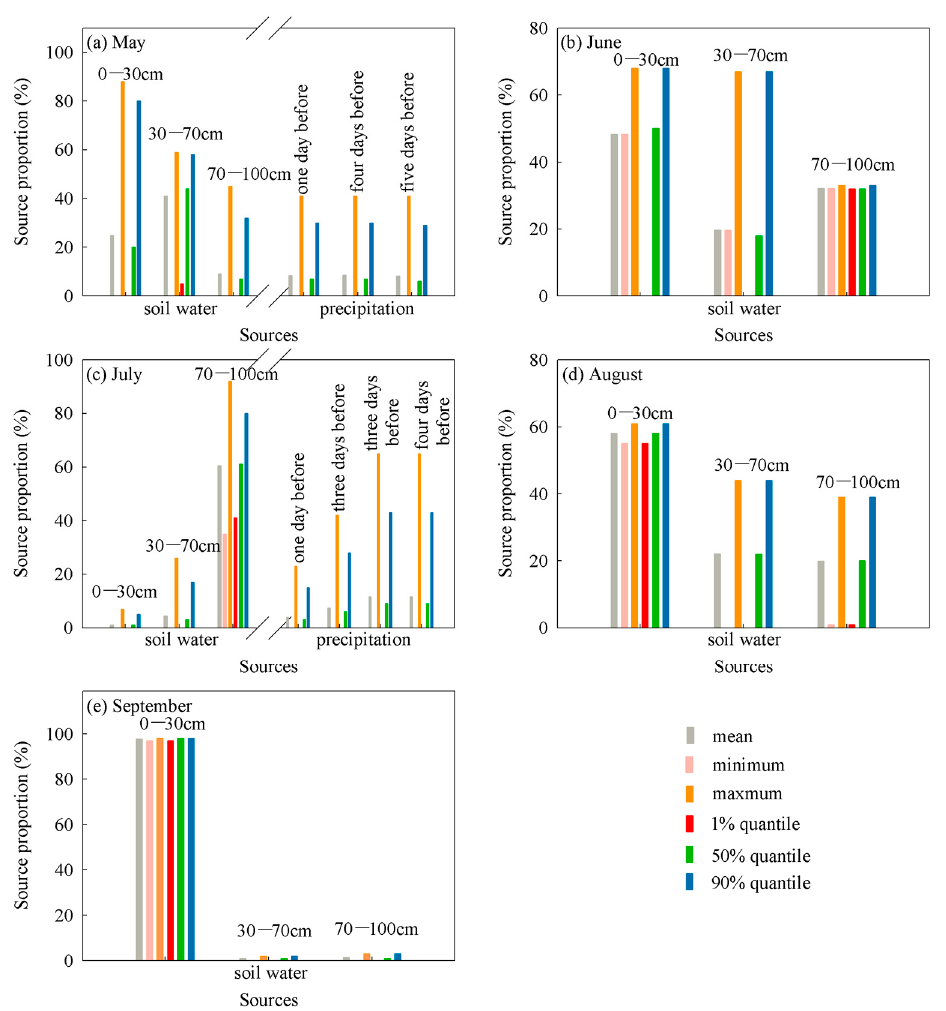
Figure 10. The fraction of plant water use from the different soil layers (0–30 cm, 30–70 cm, 70–100 cm) and precipitation at Gulang. ( a ), ( b ), ( c ), ( d ) and ( e ) represent the months of May, June, July, August, and September, respectively.